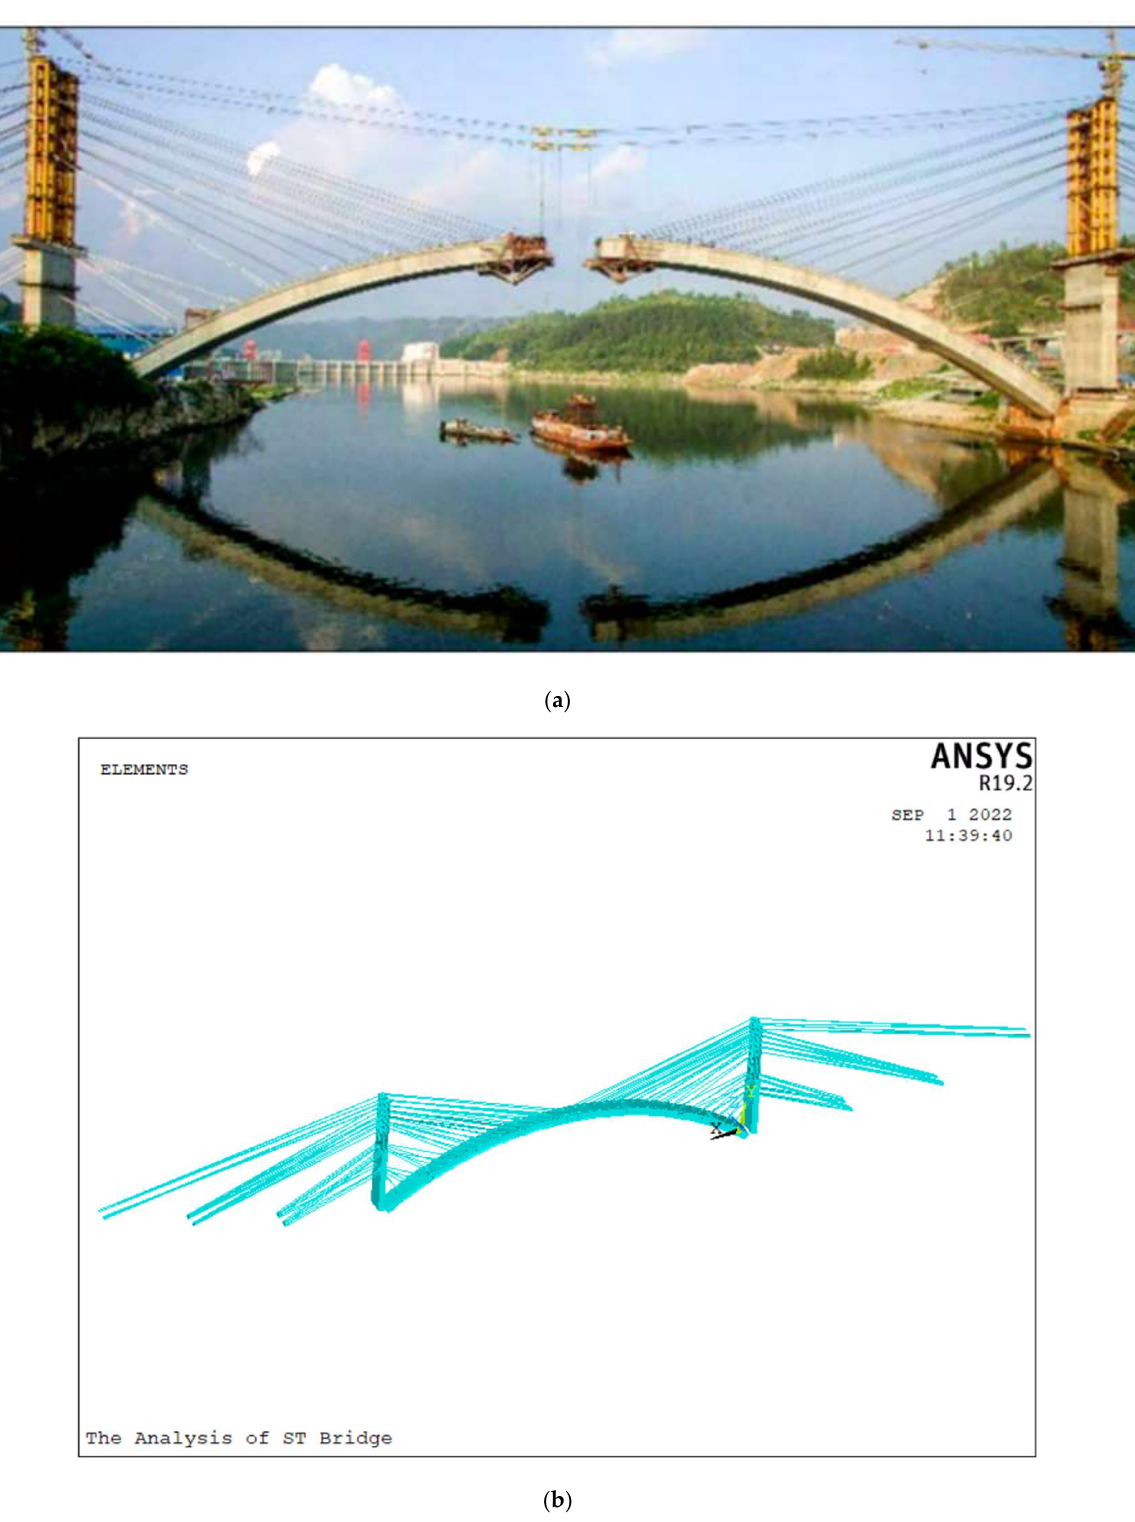
Figure 10. ( a ) Scene picture of Shatuo Bridge; ( b ) Shatuo Bridge ANSYS calculation model diagram. In order to verify the correctness and practicality of the developed elements, this pa- per uses the measured data from the Shatuo Special Bridge for comparison with the AN- SYS theoretical model data. APDL parametric modeling is used for the Shatuo Bridge; as shown in Figure 10b, the whole bridge is divided into 1808 elements and 1011 nodes, of which the 3D beam element Beam188 simulates the central arch circle, abutment pier, and buckling tower, the buckling anchor cables are simulated by the development element